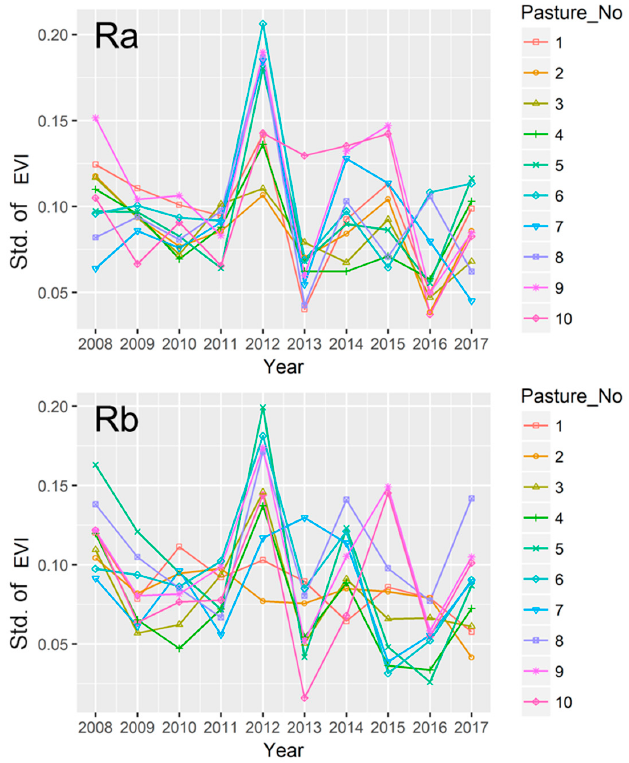
Figure 11. Growing season standard deviation EVI from Landsat 7 for paddocks in rotational grazing.